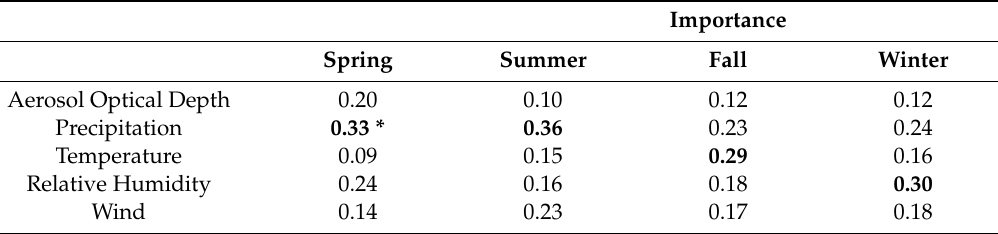
Table 4. Independent variable importance